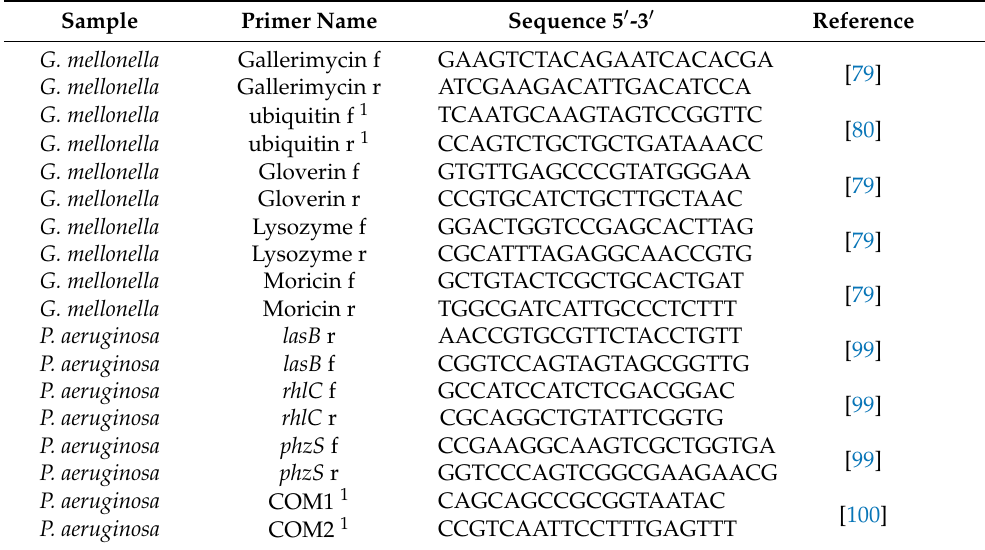
Table 2. Primers used for real-time PCR